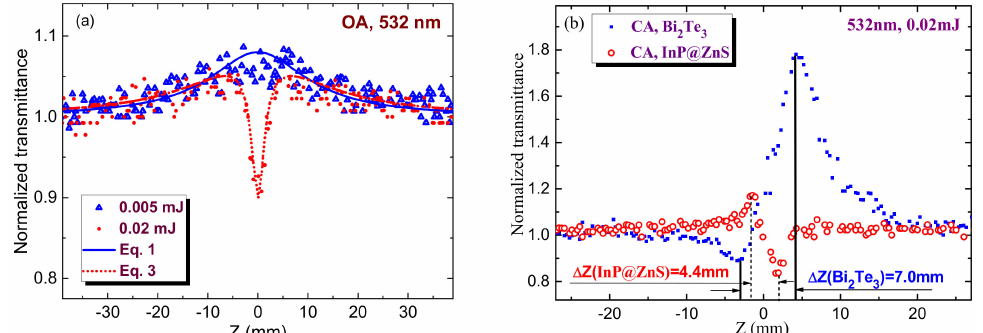
Figure 5. ( a ) Fitting of OA z-scans of core-shell QDs at two energies of probe pulses. Blue solid curve and red dotted curve correspond to the 0.005 and 0.02 mJ pulse energies, respectively. ( b ) CA z-scans of Bi 2 Te 3 nanoparticles suspension (blue filled squares) and 3.5 nm InP@ZnS core-shell QDs (red empty circles) using 0.02 mJ probe pulses. The corresponding distances between peaks and valleys of these scans were 7 and 4.4